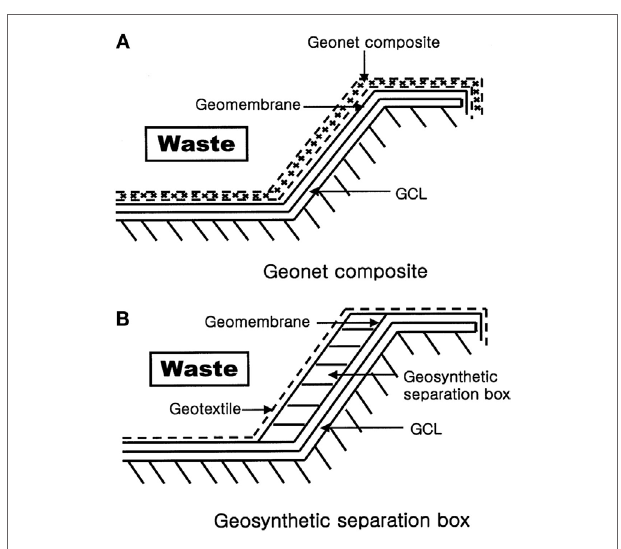
FigUre 3 | schematic diagram showing the application of the (a) geonet composite and (B) geosynthetic separation boxes to the sloping sides of a waste landfill .